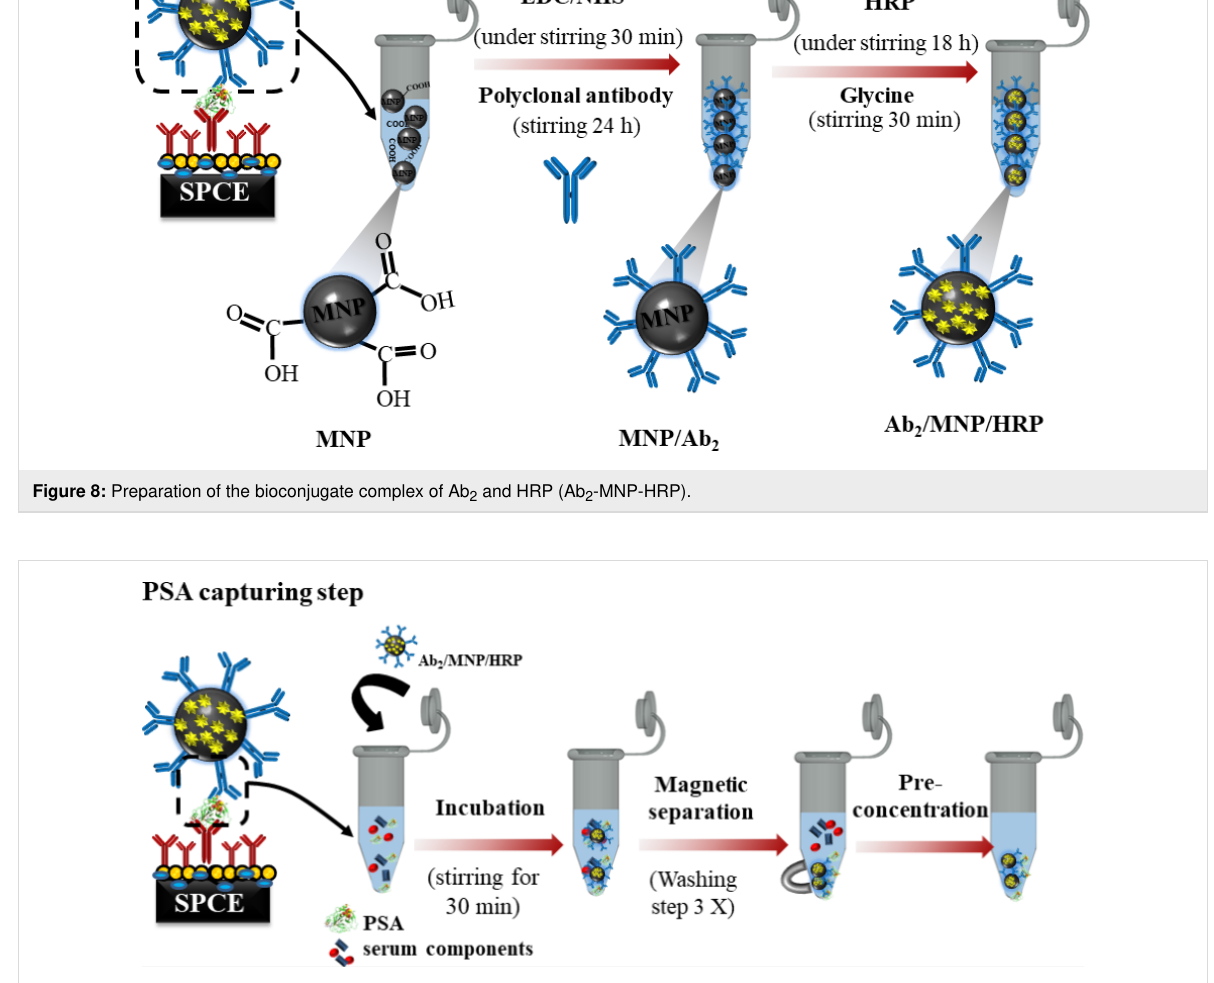
Figure 9: Illustration of the PSA capturing